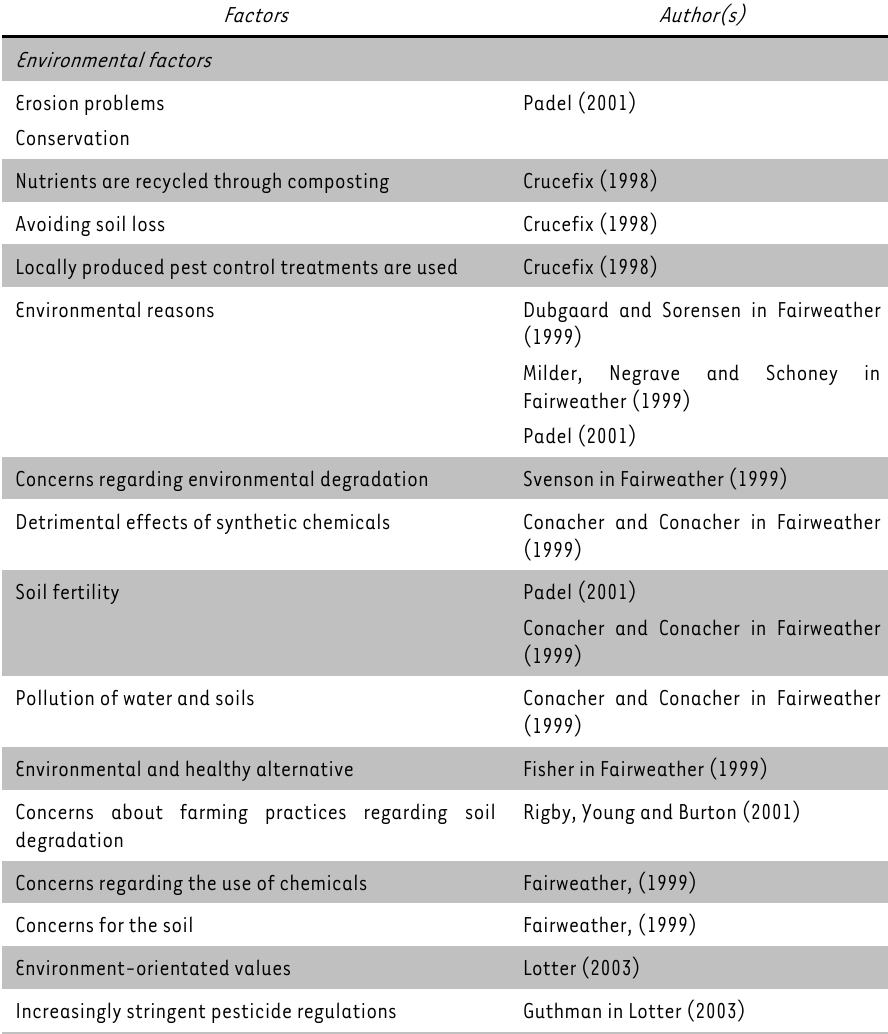
TABLE 1: Factors motivating conversion